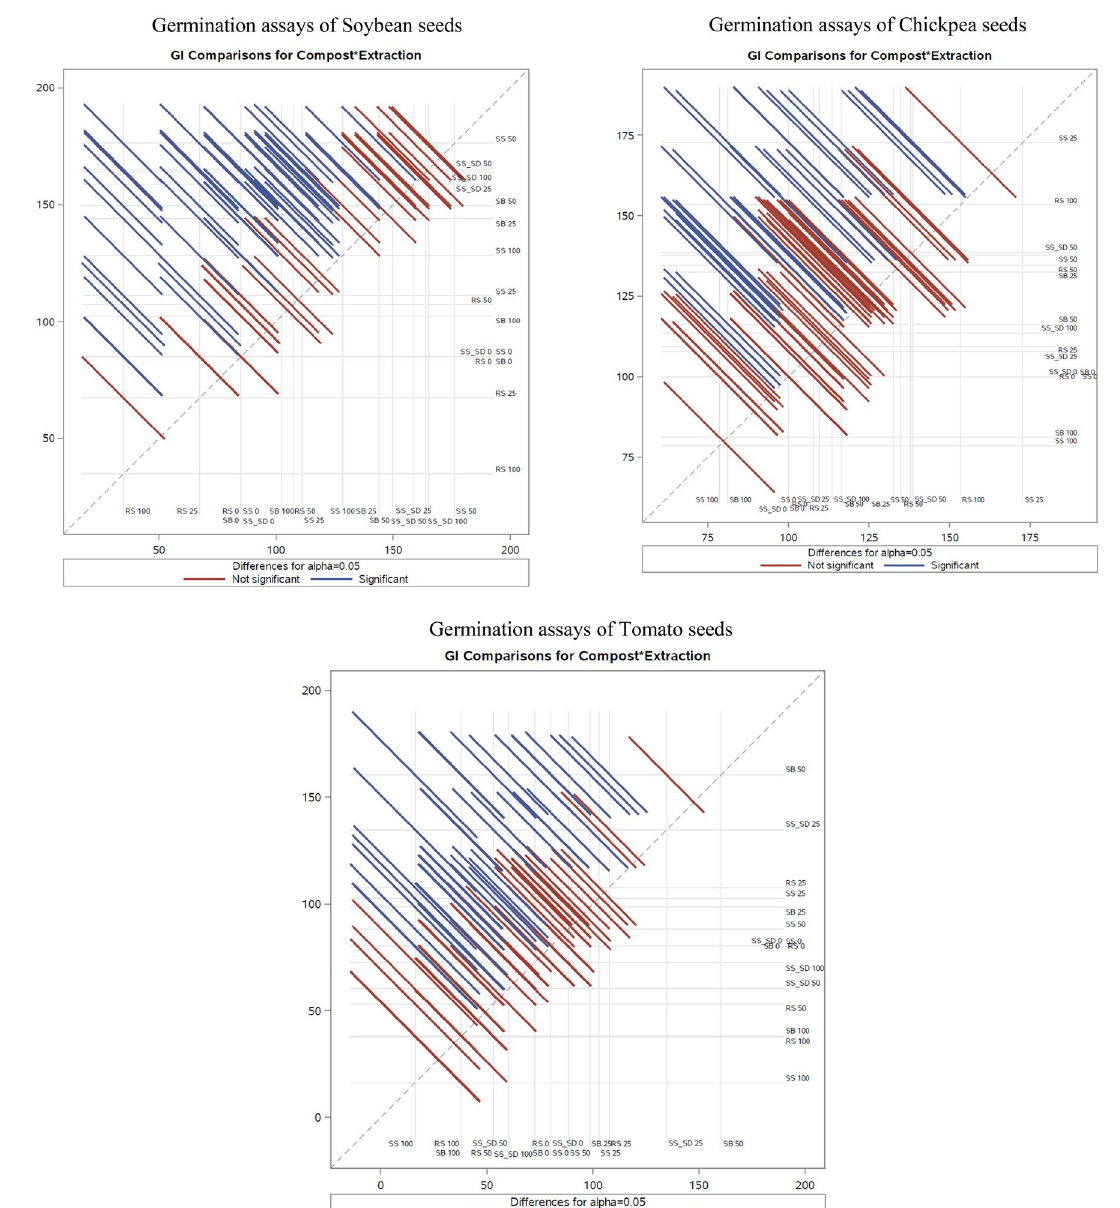
Fig. 6 Multiple comparison plots of Germination Indices of four composts and their extracts (25%, 50% and 100%) obtained during seed germination assays of tomato, chickpea and soybean. Red bars show ‘not significant” and blue bars show “significant” results of ger-